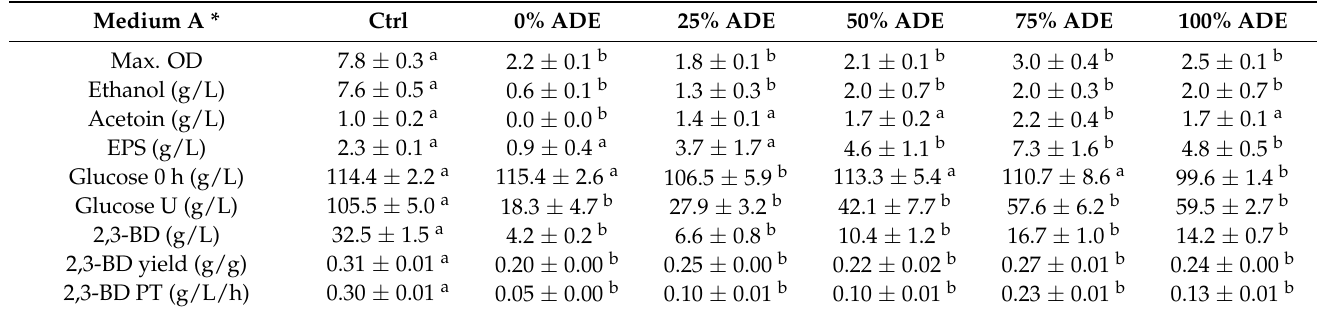
Dunnett’s pairwise comparisons between control and treatments were conducted. Values are means ± SD. Means with different letters across each row vary significantly at p < 0.05; EPS: exopolysaccharides; 2,3-BD: 2,3-butanediol. * Glucose U: glucose utilized; 2,3-BD PT: 2,3-BD productivity.